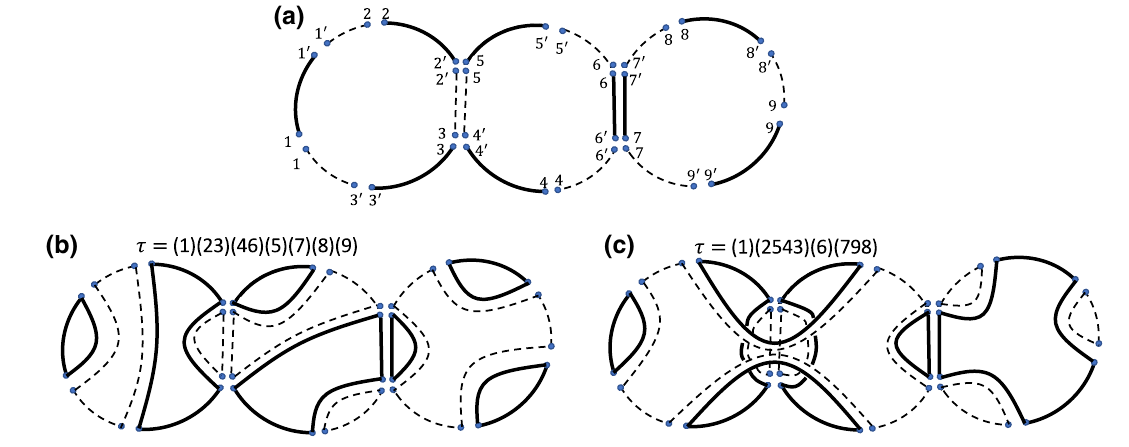
FIG. 15. Examples of the diagrammatic representation for Eq. (B16) for n = 3 and m = 3. (a) The “future conditions” common to all diagrams for with m = 3. (b),(c) Examples of interior connections for two different choices of τ